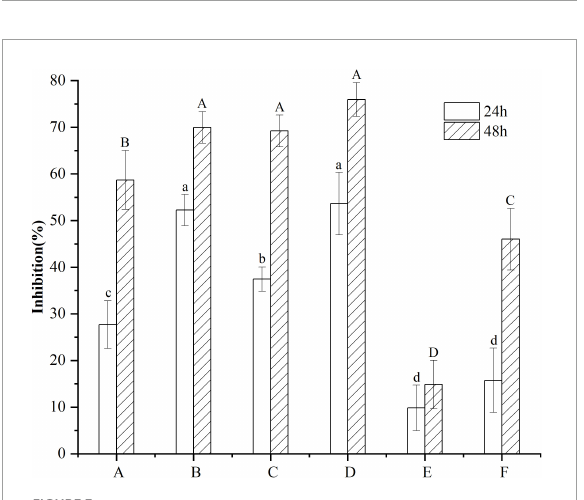
FIGURE2 Contents of DMY and MYT in the extract of different vine teas. Values are means ± SD ( n = 3). Different groups of vine tea were prepared at 1 mg/mL, DMY and MYT standards were prepared at different concentrations with methanol solution and were determined by HPLC. Different letters and capitalization indicate significant differences between means at P < 0.05 by one-way ANOVA followed by Duncan comparison test. DMY, dihydromyricetin; MYT, myricitrin.